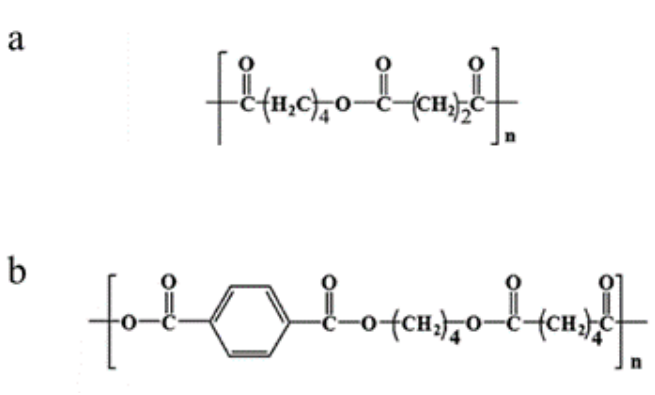
Figure 1. Chemical structure of ( a ) PBS and ( b ) PBAT.